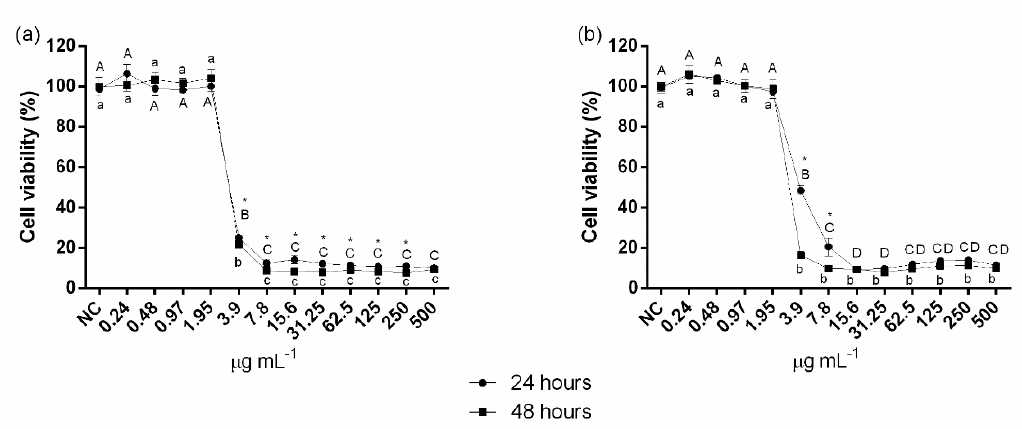
Figure 6. Cytotoxic potential evaluated by MTT reduction assay. Cell viability percentages of L929 murine fibroblasts after exposure for 24 or 48 h to different concentrations (0.24–500 µg mL − 1 ) of cetylpyridinium chloride ( a ) and iron oxide nanoparticles-chitosan-cetylpyridinium chloride nanocarrier ( b ). Negative control (NC) represents murine fibroblasts exposed to pure culture medium (without drugs). Error bars represent standard deviations of the means. Different uppercase and lowercase letters indicate significant differences among the different concentrations of the compounds, respectively for 24 and 48 h of exposure. *Indicates significant difference between 24 and 48 h of exposure, within each concentration tested (two-way ANOVA followed by Tukey’s test; p < 0.05).